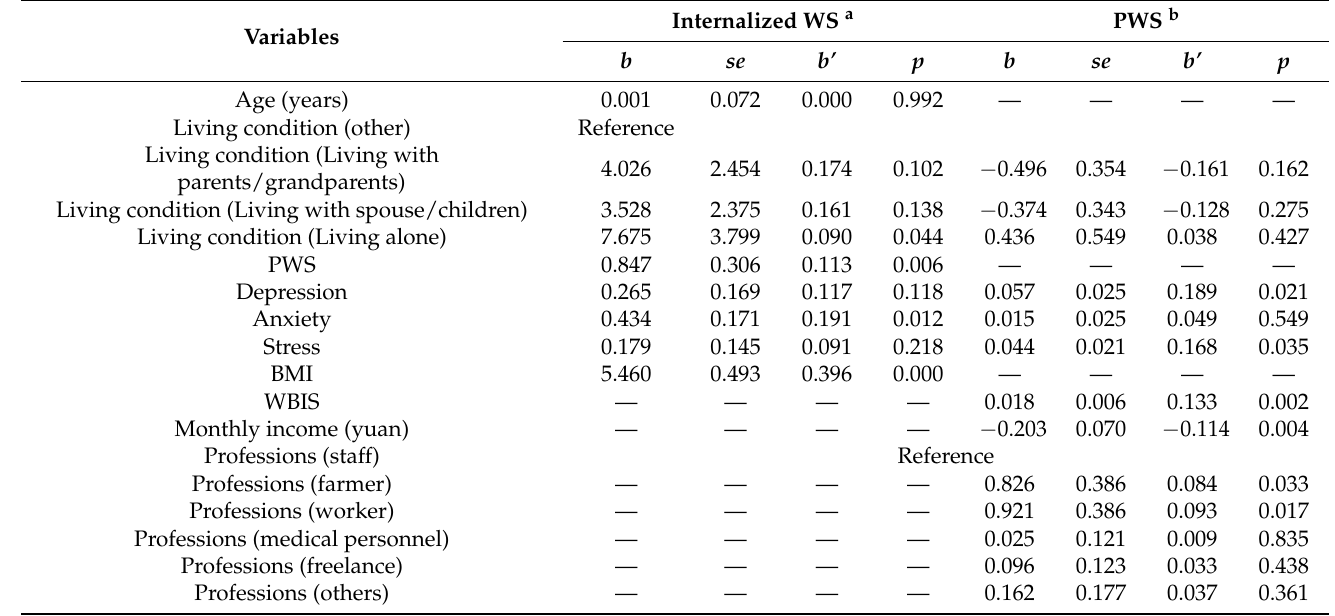
Table 6. Multiple Regression Analysis with Internalized Weight Stigma and PWS as Dependent Variables (N =